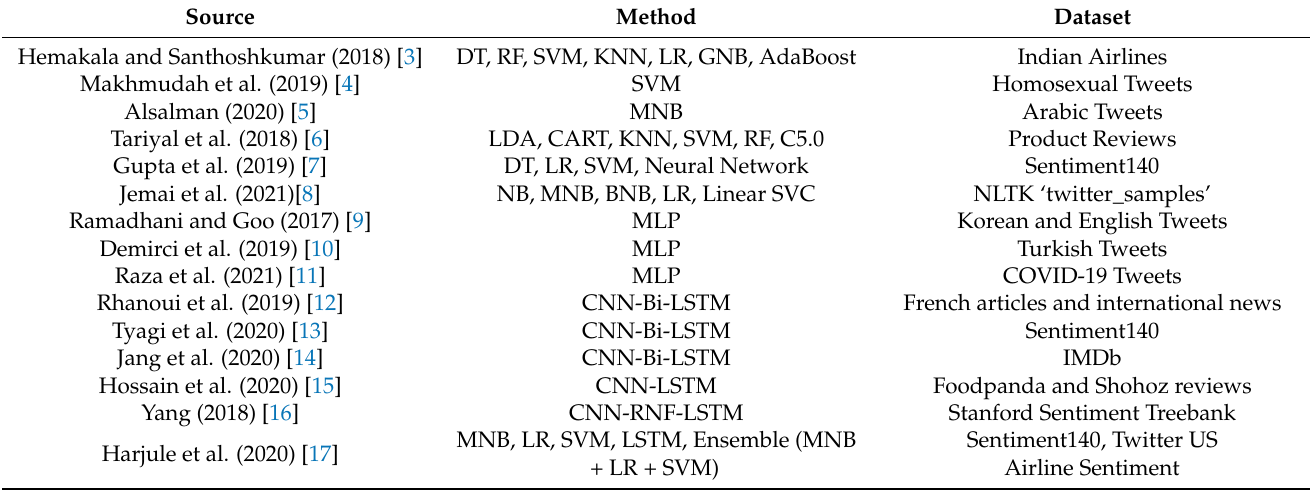
Table 1. The summary of the related